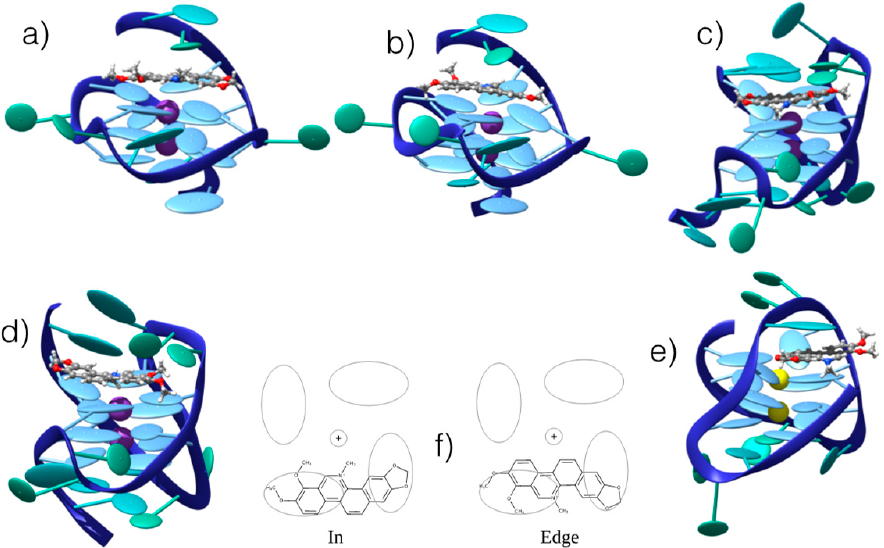
Figure 5. Representative snapshots of the persistent interaction modes between CHE and G4 in hybrid, parallel, and antiparallel conformations from different sequences (see Methods): ( a ) “edge”/parallel; ( b ) “in”/parallel; ( c ) “edge”/hybrid; ( d ) “in”/hybrid; ( e ) “edge”/antiparallel. ( f ) Schematic representation of the competitive “in” and “edge” interaction modes. The ellipsoids represent π -stacked nucleobases in the G4 core. Note that for antiparallel G4, only one stable interaction mode has been obtained.